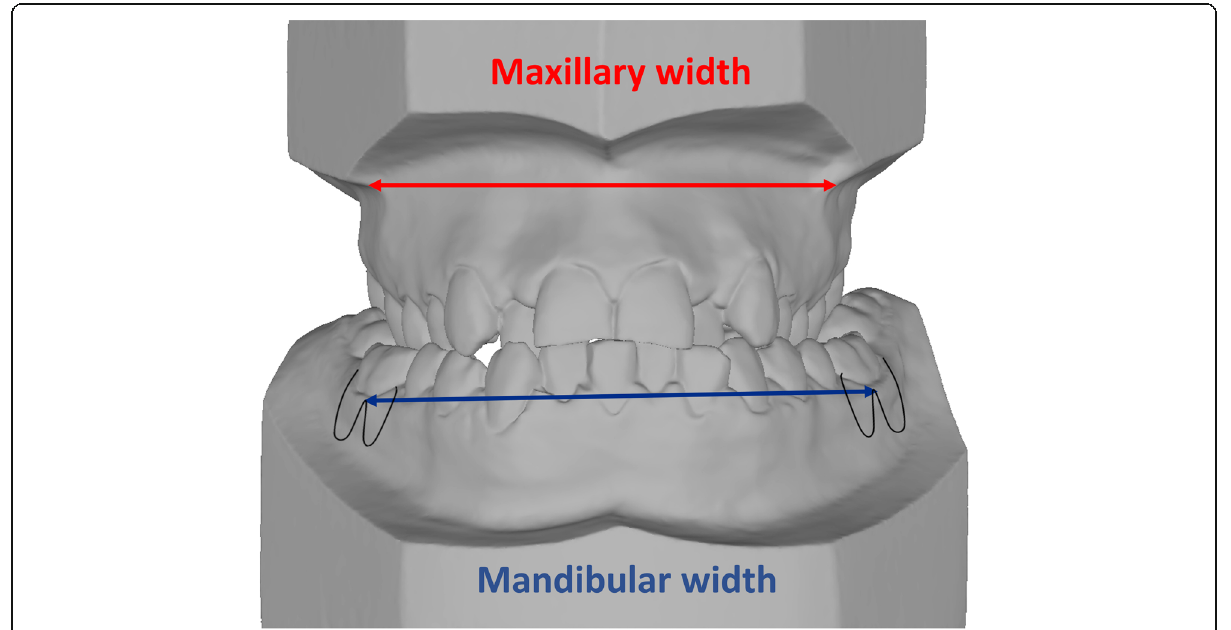
Fig. 2 Method used to diagnose transverse maxillary skeletal deficiency. Red line: maxillary width. Blue line: mandibular width